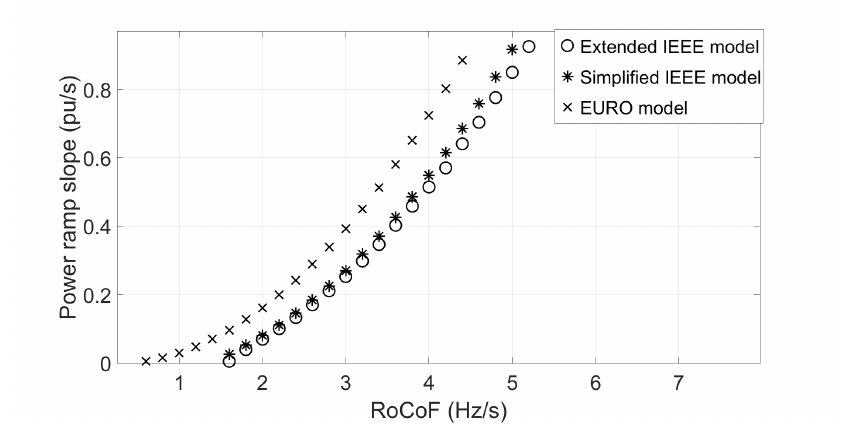
Figure 13. Comparison of the results of the three models in terms of the IBFPR power ramp which is needed at 80% of the share from non-synchronous generation.